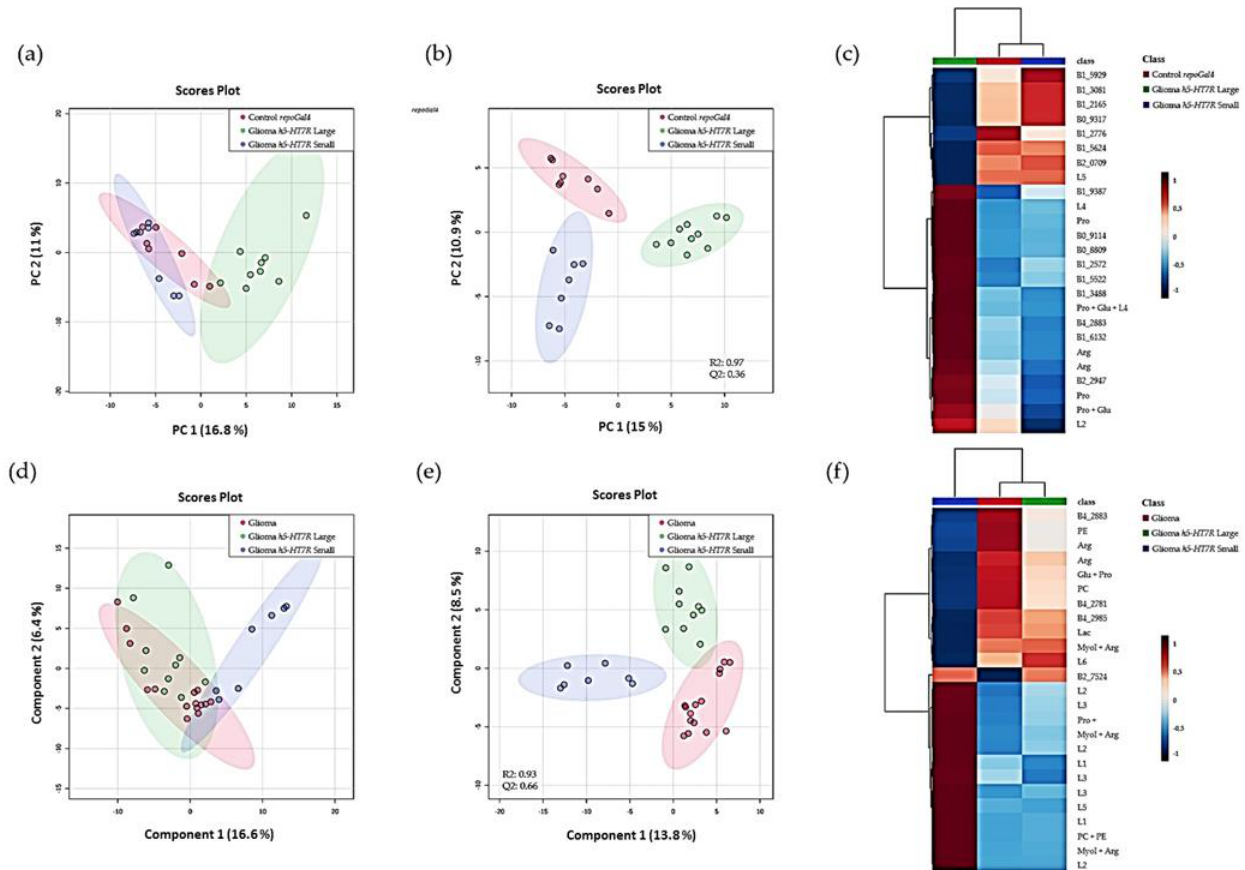
Figure 6. HR-MAS based metabolomics results. ( a – c ) Comparison of controls brains (repo-Gal4), and brains expressing h5-HT7R in a glioma context (“small” brains and “large” brains). ( d – f ) Comparison of gliomas and brains expressing h5-HT7R in a glioma context (“small” and “large” brains). ( a , d ) Unsupervised multivariate analysis PCA, ( b , e ) PLS–DA score plot, ( c , f ) Heat map of the first 25 most significant buckets with group averaging. R2 is the percentage of the data explained by the supervised model and Q2 is the quality of the prediction. Arg: arginine; Glu: glutamate; Lac: lactate; MyoI: myoinositol; PC: phosphocholine; PE: phosphoethanolamine; Pro: proline; L1, L2, L3, L4, L5 and L6: lipids. L1: CH 3 ; L2: (CH 2 ) n ; L3: CH 2 - CH 2 -CO ; L4: CH 2 - C= ; L5: CH 2 - CO; L6: CH=CH .